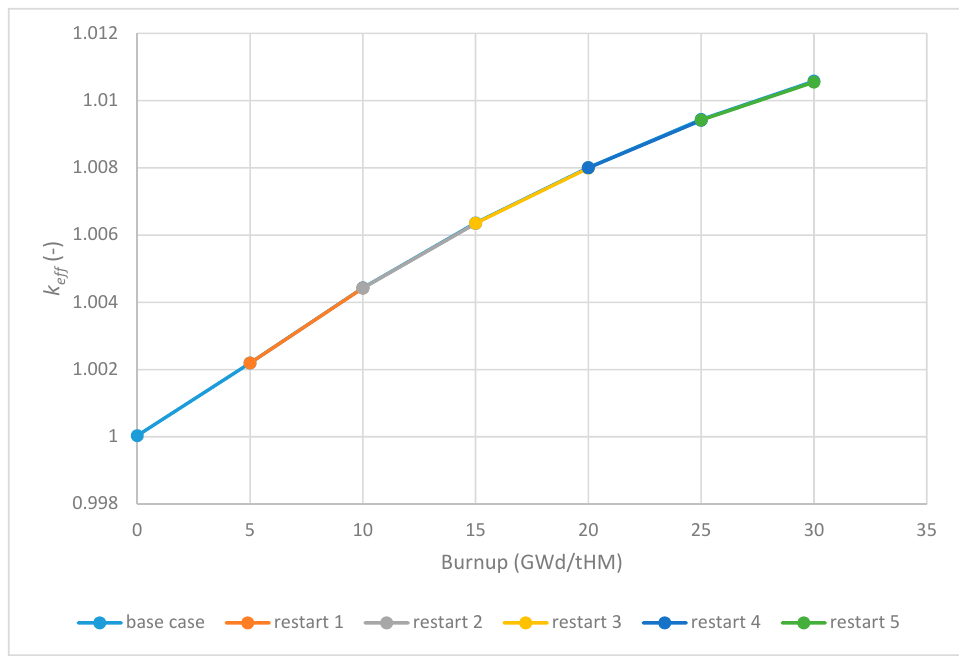
Figure 5. Criticality versus burnup evaluation of the base case and the case with 142 isotopes tracked during the restart to assure a reliable restart of the calculation.